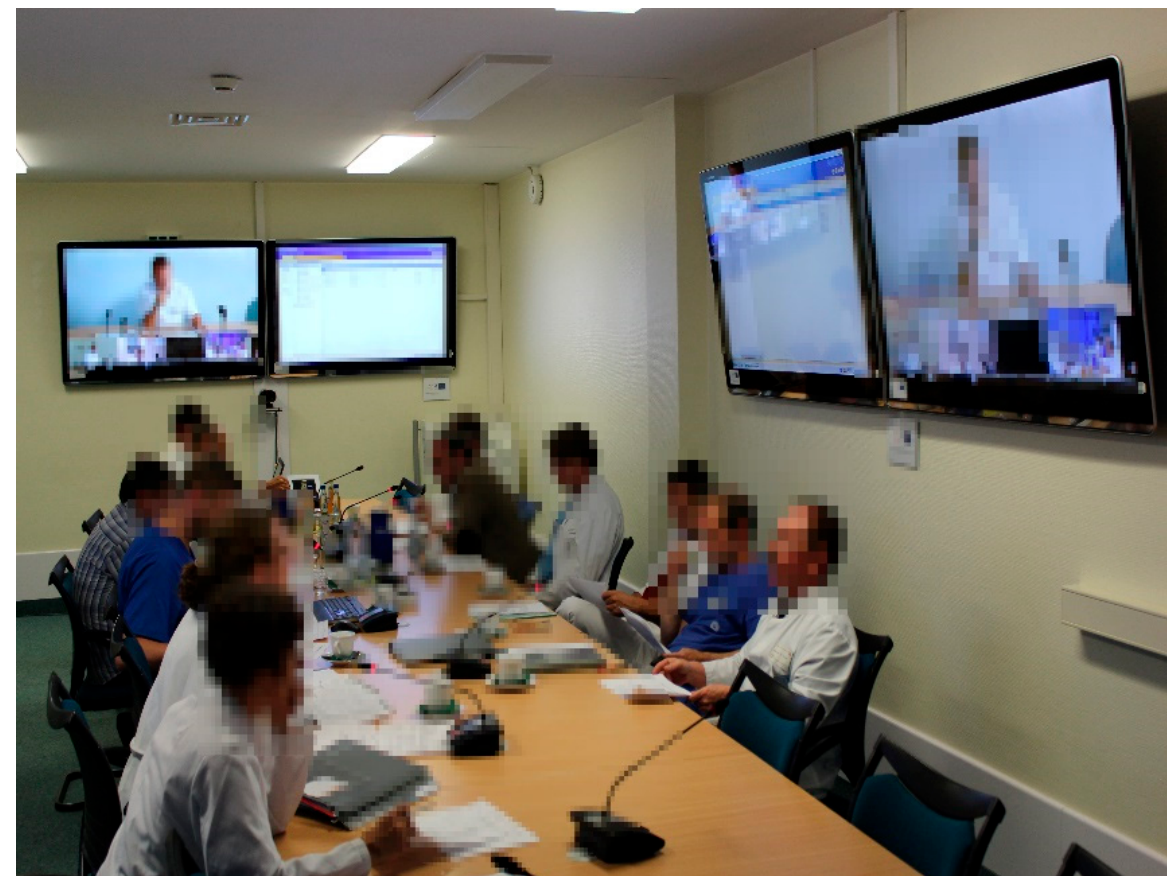
Figure 5. Tele - Tumour Conferencing. A sophisticated subproject included the tumour board of Figure 5. Tele-Tumour Conferencing. A sophisticated subproject included the tumour board of Eberswalde hospital, where smaller hospitals presented their cancer patients to specialists. Seated at the conference table are oncologists, a radiation oncologist and a radiologist. A pathologist in Pasewalk is discussing cases with a referring physician from the Templin hospital, approximately 65 km away. Documents, X-rays and pathology slides can be viewed by all participants